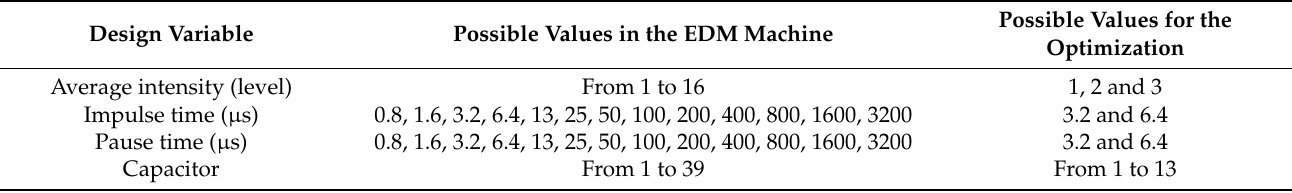
Table 5. Design variables and possible values for the